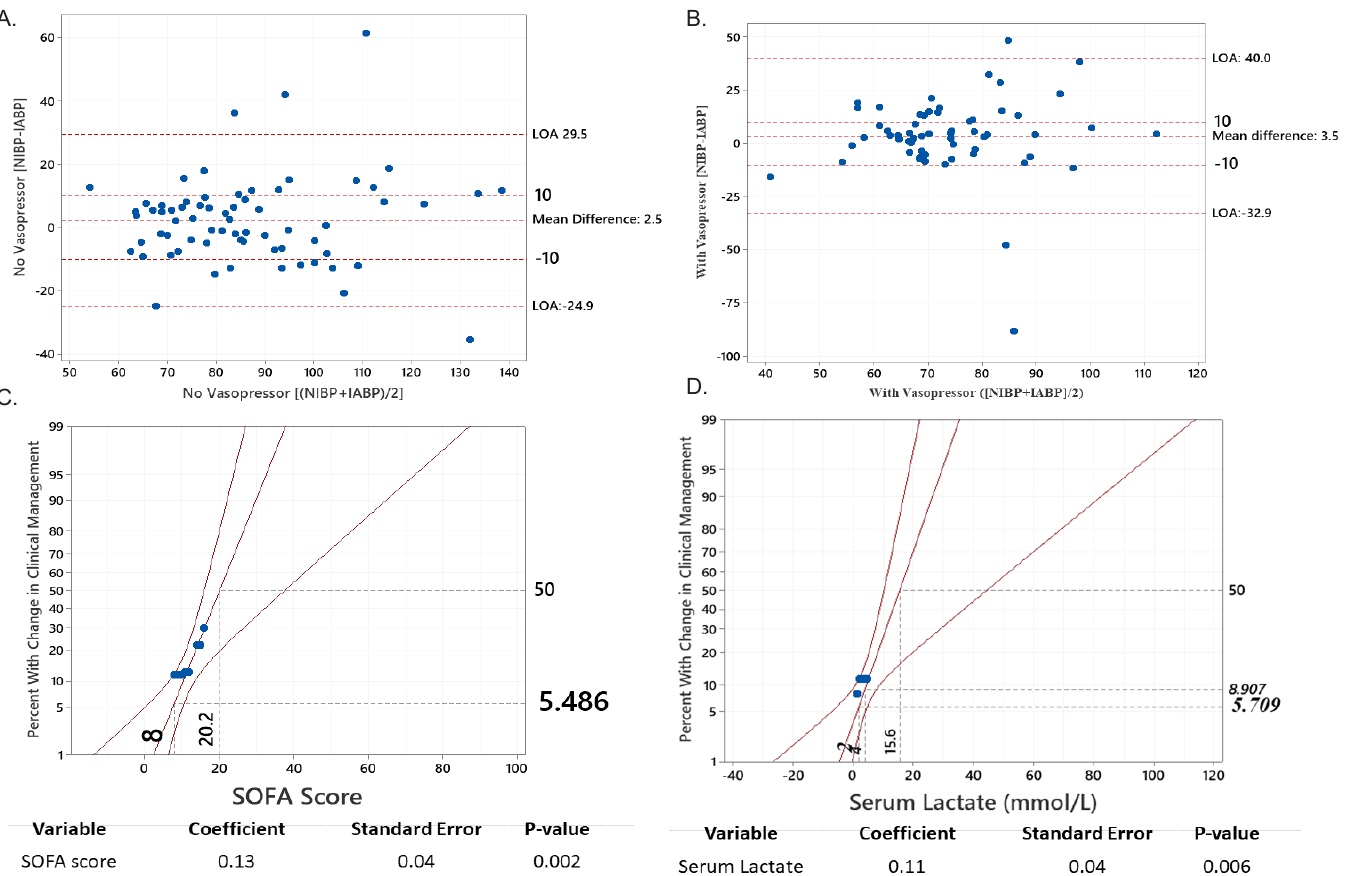
Figure 2. (A)Bland-Altman plot displaying blood pressure differences among septic patients without vasopressors. The noninvasive blood pressure (NIBP) and invasive arterial (IA) BP discrepancy was distributed evenly throughout the X-axis, demonstrating that the difference between the two modalities occurred when patients were hypotensive or normotensive. Additionally, the difference between NIBP and IABP on the Y-axis was mostly concentrated between the level of -10 mm Hg and +10 mm Hg, demonstrating that the NIBP modality has equal likelihood to be higher or lower than IABP. (B) Bland-Altman plot displaying blood pressure differences among septic patients with vasopressors. There were even distributions of NIBP-IABP* discrepancies along the X-axis, demonstrating that the difference between